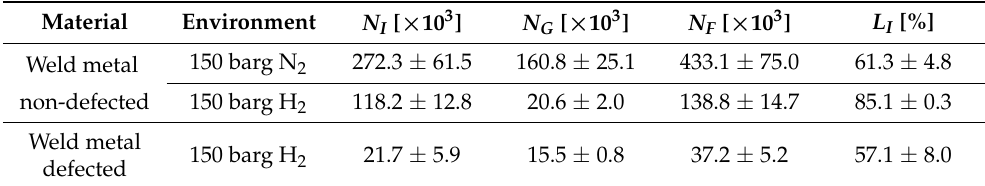
Table 5. An overview of the 150 barg tested weld metal fatigue results including defected specimens, presenting the number of cycles spent in the crack initiation phase ( N I ), the growth phase ( N G ), the cycles until failure ( N F ) and percentage of lifetime spent in the crack initiation phase ( L I ). Errors are standard